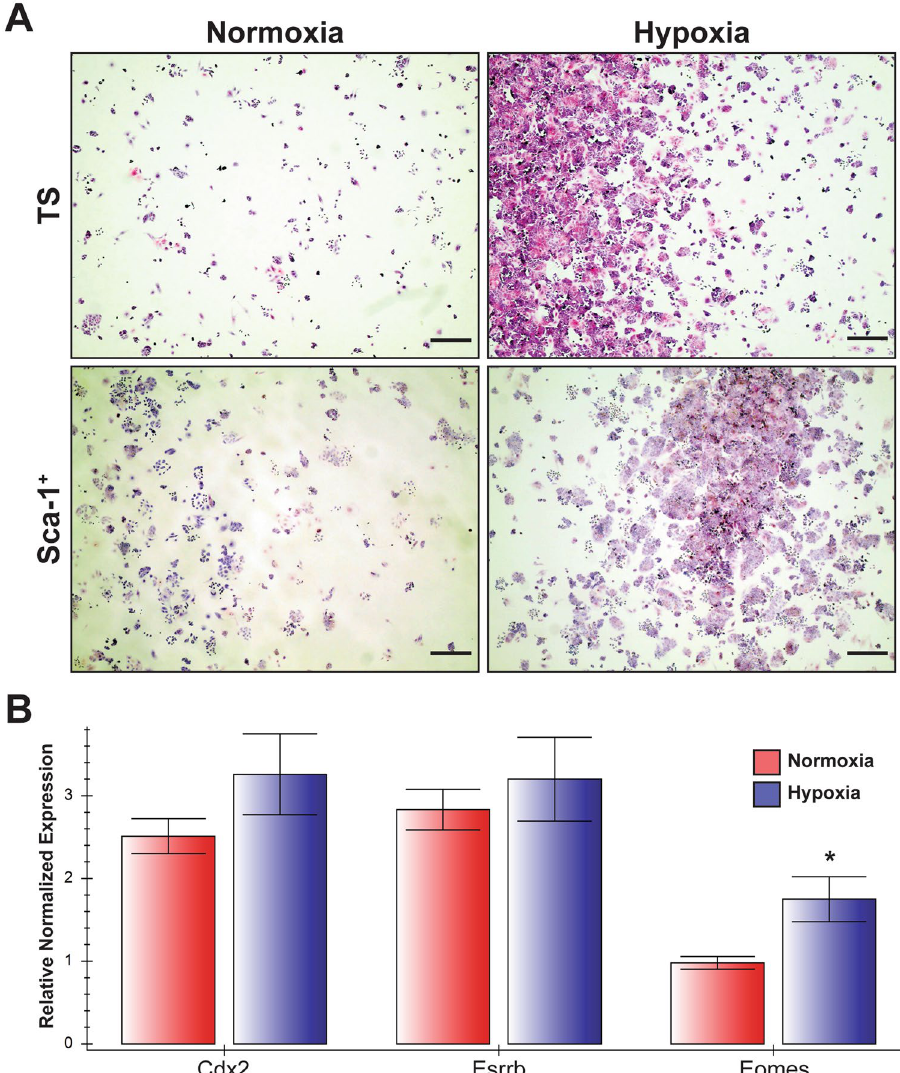
Figure 9. Sca-1 + trophoblast isolated from differentiated TS cell cultures were re-plated in TS media plus growth factors and cultured in 5% CO 2 in air (Normoxia) or 1% O 2 (Hypoxia) for 48 hours. These cultures were compared to proliferating, non-sorted TS cells plated in the same conditions and at the same seeding density (TS). Hypoxia promoted colony formation and proliferation compared to normoxia ( A ). After 48 hours of culture in hypoxia in the presence of growth factors, expression of Cdx2 and Esrrb in Sca-1 + trophoblast was maintained, while Eomes expression was up regulated in these cells as detected by qRT-PCR ( B ). Cells were stained with hematoxylin and eosin. Scale bar = 500